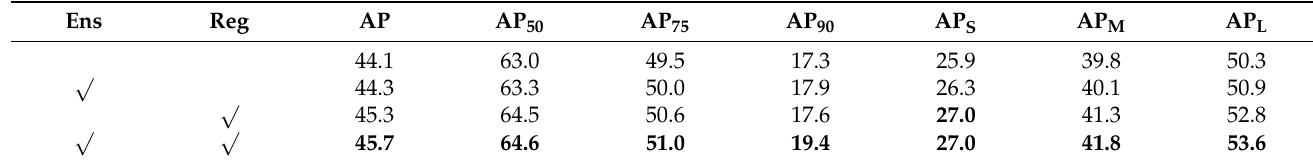
Table 3. Ablation experiments for a five-stage Cascade R-CNN++ on the DOTA-v1.5 dataset. “Ens” indicates using the new ensemble strategy for classification at inference. “Reg” indicates using the modified loss function for bounding box regression at both training and inference, all with Resnet-50 backbone.